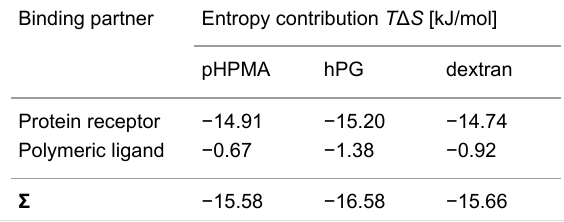
Table 3: Calculated changes in entropy during binding of the multiva- lent polymeric ligands to the bivalent receptor by molecular dynamics